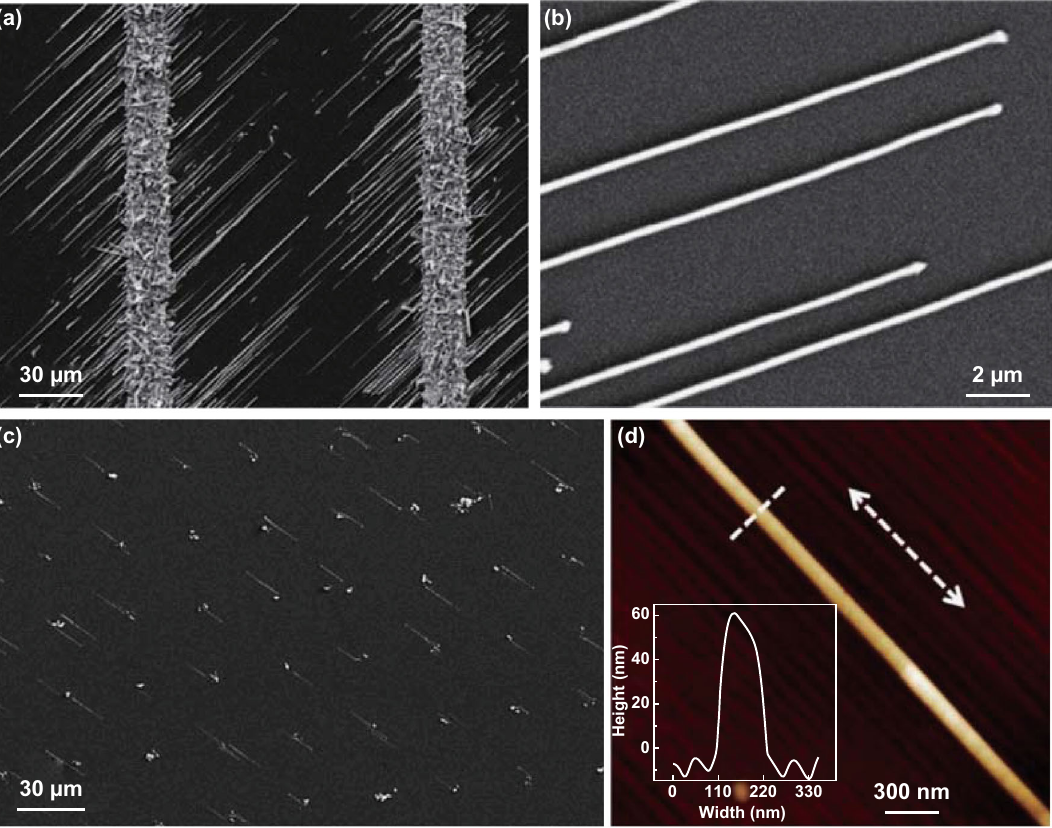
Fig. 2 Morphology characterization of the directional CdS x Se 1 - x NWs. a SEM images of the as-grown CdS x Se 1 - x NWs along the pre-defined photolithography line-patterned Au catalyst. b High-magnification SEM images of the as-grown samples, showing strong horizontal alignment of the NWs along the substrate. c SEM images of the CdS x Se 1 - x NWs grown along the pre-defined catalytic nanoparticles by EBL. d AFM images of the directional CdS x Se 1 - x NWs, inset shows the size profile of the NW of the dashed line marked position in ( d